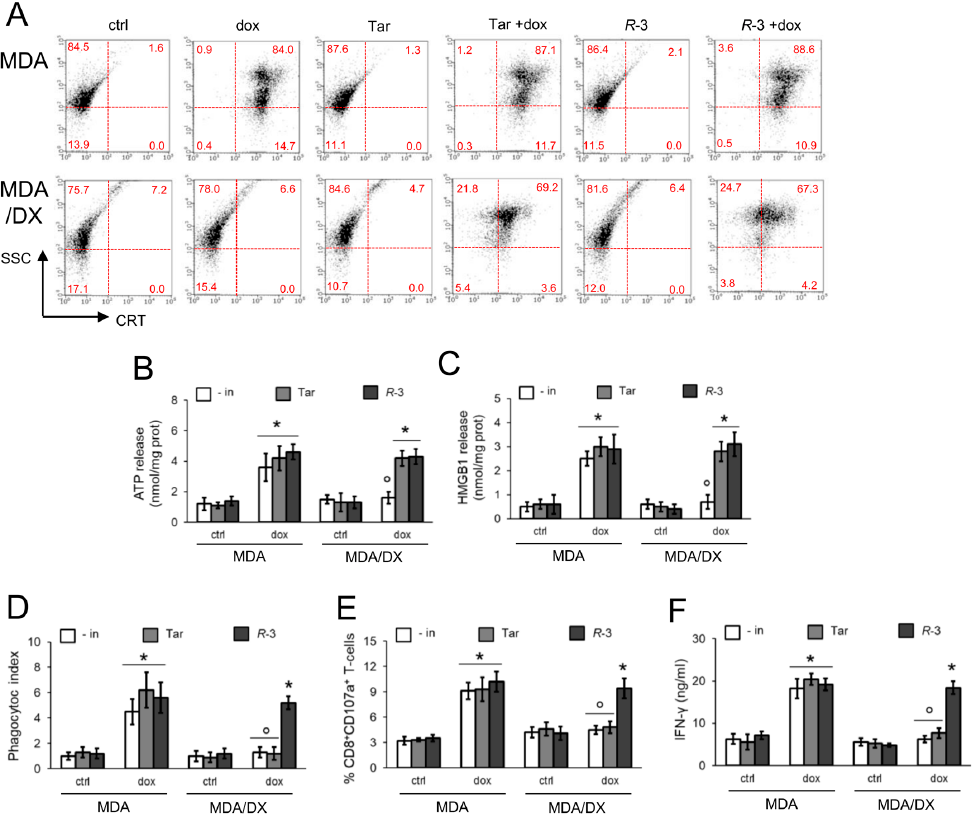
Figure 3. R -3 but not Tariquidar rescues the immunogenic cell death induced by doxorubicin in Pgp-expressing cells. ( a ) Human triple-negative breast cancer MDA-MB-231 cells and their doxorubicin (DX)-resistant variant were incubated 6 h ( a and b ) or 24 h ( c – f ), in fresh medium (ctrl) or in medium containing 5 µ M doxorubicin (dox). Cells were grown without inhibitors (- in), with 75 nM Tariquidar (Tar) or 75 nM R -3. ( a ) Dot plots representative of surface calreticulin (CRT), performed by flow cytometry in duplicate ( n = 3). Numbers represent the percentage of cells/quadrant. Cut-off for positivity was fixed at 10 2 . SSC: side-scatter. The image is representative of 1 out of 3 experiments. ( b ) Release of extracellular ATP, measured by a chemiluminescence-based assay in duplicates ( n = 3). Data are means ± SD. * p < 0.001: treated cells vs. respective ctrl cells; ° p < 0.001: DX cells vs. parental cells. ( c ) Release of extracellular HMGB1, measured by ELISA in duplicates ( n = 3). Data are means ± SD. * p < 0.001: treated cells vs. respective ctrl cells; ° p < 0.001: DX cells vs. parental cells. ( d ) After the treatments indicated in panel ( c ), tumor cells were stained with FITC-PKH2 dye and DCs were stained with an anti-PE-HLA-DR antibody. Tumor cells were co-incubated with DCs for 24 h. Double-stained cells were counted by flow cytometry. Data are means ± SD ( n = 3). * p < 0.001: treated cells vs. respective ctrl cells; ° p < 0.001: DX cells vs. parental cells. ( e ) T-lymphocytes were co-cultured with DCs after phagocytosis, and then incubated 24 h with MDA-MB-231 or MDA-MB-231/DX cells. The percentage of CD8 + CD107a + T-cells was measured by flow cytometry. Data are means ± SD ( n = 3). * p < 0.001: treated cells vs. respective ctrl cells; ° p < 0.001: DX cells vs. parental cells. ( f ) IFN- γ concentration was measured in the supernatants of T-lymphocytes, treated as indicated in ( e ), by ELISA in duplicates. Data are means ± SD ( n = 3). * p < 0.001: treated cells vs. respective ctrl cells; ° p < 0.001: DX cells vs. parental cells.